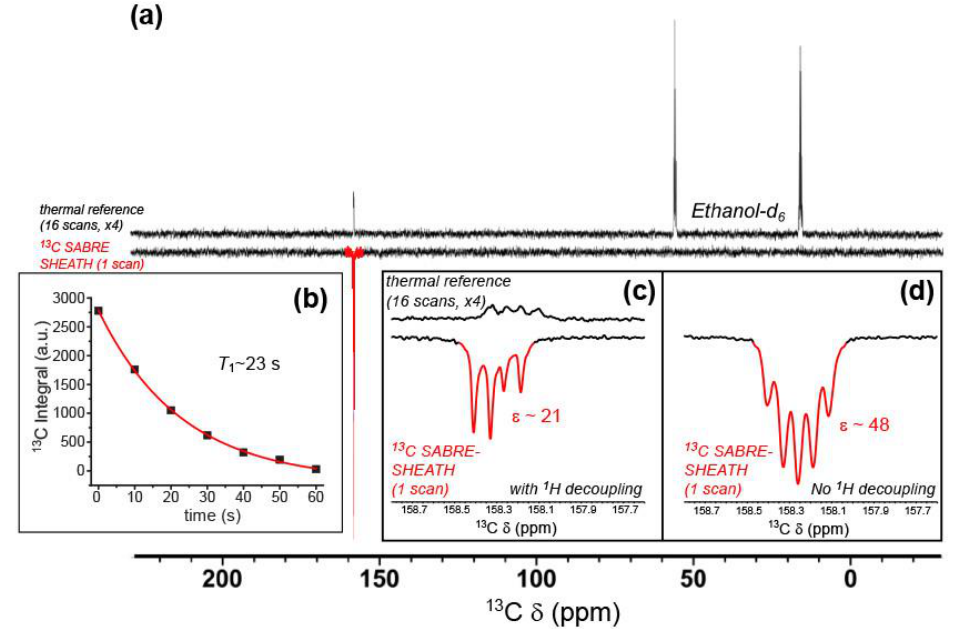
Figure 9. ( a ) 13 C NMR SABRE-SHEATH of doubly-labeled cytosine ( bottom ), compared to a thermally polarized reference scan from the same sample (16 scans, top ). Close-ups of the cytosine resonances from these spectra, both taken under conditions of broadband 1 H-decoupling, are shown in ( c ); enhancement ( ε ) ~21-fold. ( b ) The hyperpolarization decay curve for the integrated cytosine carbonyl 13 C resonance, obtained from a second set of SABRE-SHEATH experiments (measured at 9.4 T; each point is a separate experiment with variable delay time at high field prior to acquisition), yielding T 1 of 22.9 ± 0.8 s. Data points were taken from spectra obtained without 1 H decoupling, an example of which is shown in ( d ); ε ~48-fold; that spectrum also has a very weak, broad peak at 150 ppm (not shown) that is tentatively assigned to cytosine bound to the catalyst.